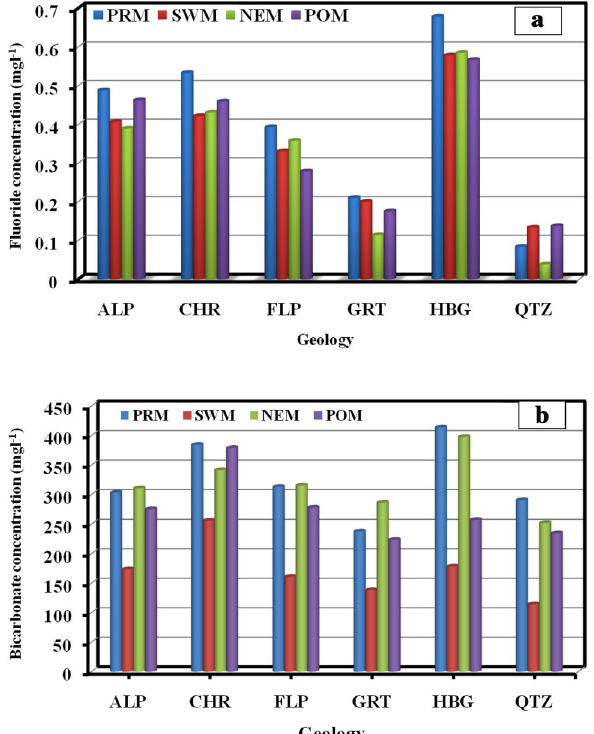
3 for samples collected during different seasons